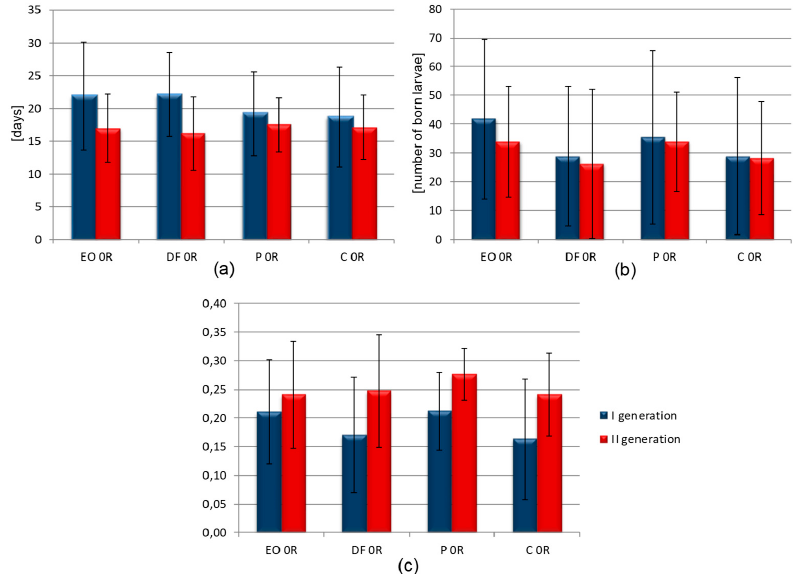
Figure 3. The effect of petroleum-derived substances on: mean lifespan [days]—( a ); mean fecundity— ( b ); population intrinsic growth rate (r m )—( c ) of Aphis fabae Scop. Vertical bars mean SE (standard error). Symbols as in Figure 1. There were no statistically significant differences between the treatments.